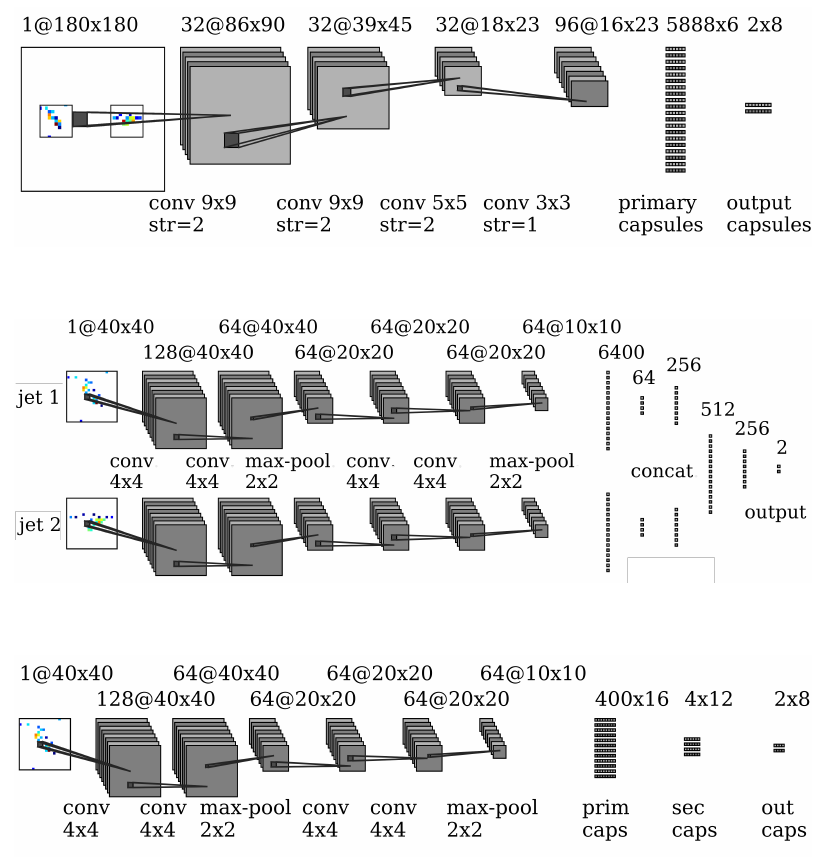
Figure 4: Top: convolutional CapsNet architecture based on stride-convolutions, used for di-Top tagging. Center: scalar CNN di-top tagger using the Rutgers D EEP T OP architecture [ 26,27 ] . Bottom: CapsNet single top jet tagger